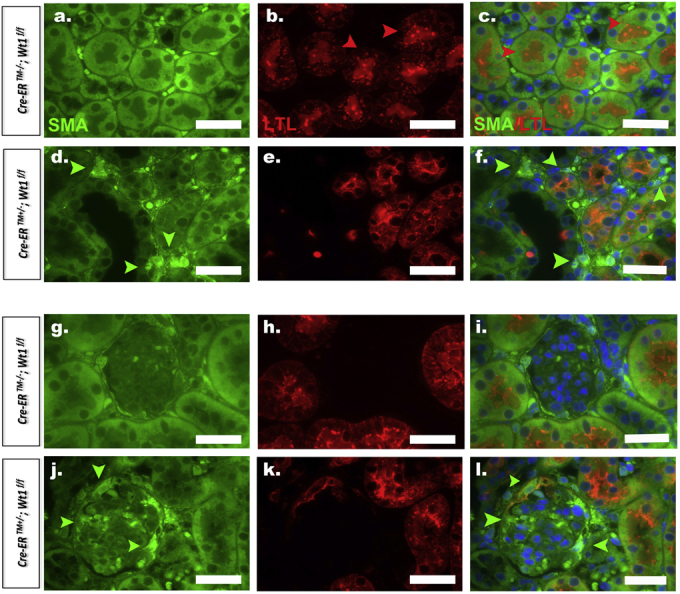
Induction of vascular smooth muscle actin expression in CreERTM+/−;Wt1f/f transgenic mice. (A-F) Shown are micrographs of glomeruli following double immunofluorescence labeling of transgenic mouse kidney tissue sections with anti-α smooth muscle actin (SMA) (Alexa Fluor 488–conjugated secondary antibody) and Lotus tetragonolobus lectin (LTL) (Alexa Fluor 594–conjugated secondary antibody) at day (D) 12 PI. Images were counterstained with 4′,6-diamidino-2-phenylindole. Bars = 50 μm. (A–F) Expansion of α-SMA expression is noted in tubulointerstitial compartment in mutants (D) compared with controls (A). (C,F) High-power views of tubulointerstitium. α-SMA expression (green arrows) is induced in peritubular cells (red arrows, tubules) in CreERTM+/−;Wt1f/f transgenic mice (F) that is not seen in control CreERTM−/−;Wt1f/f transgenic mice (C). Bars = 50 μm. (G–L) High-power views of proximal nephron and glomeruli. Vascular SMA expression (green arrows) is observed in CreERTM+/−;Wt1f/f transgenic mice (L) in clusters of glomerular cells within Bowman’s capsule, intraglomerular tuft region, and the parietal epithelium in CreERTM+/−;Wt1f/f and not in control CreERTM−/−;Wt1f/f transgenic mice (G). Bars = 50 μm.